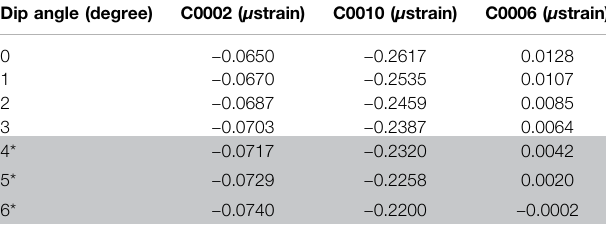
*Shaded background shows out of range for acceptable volumetric strain change at C0006.